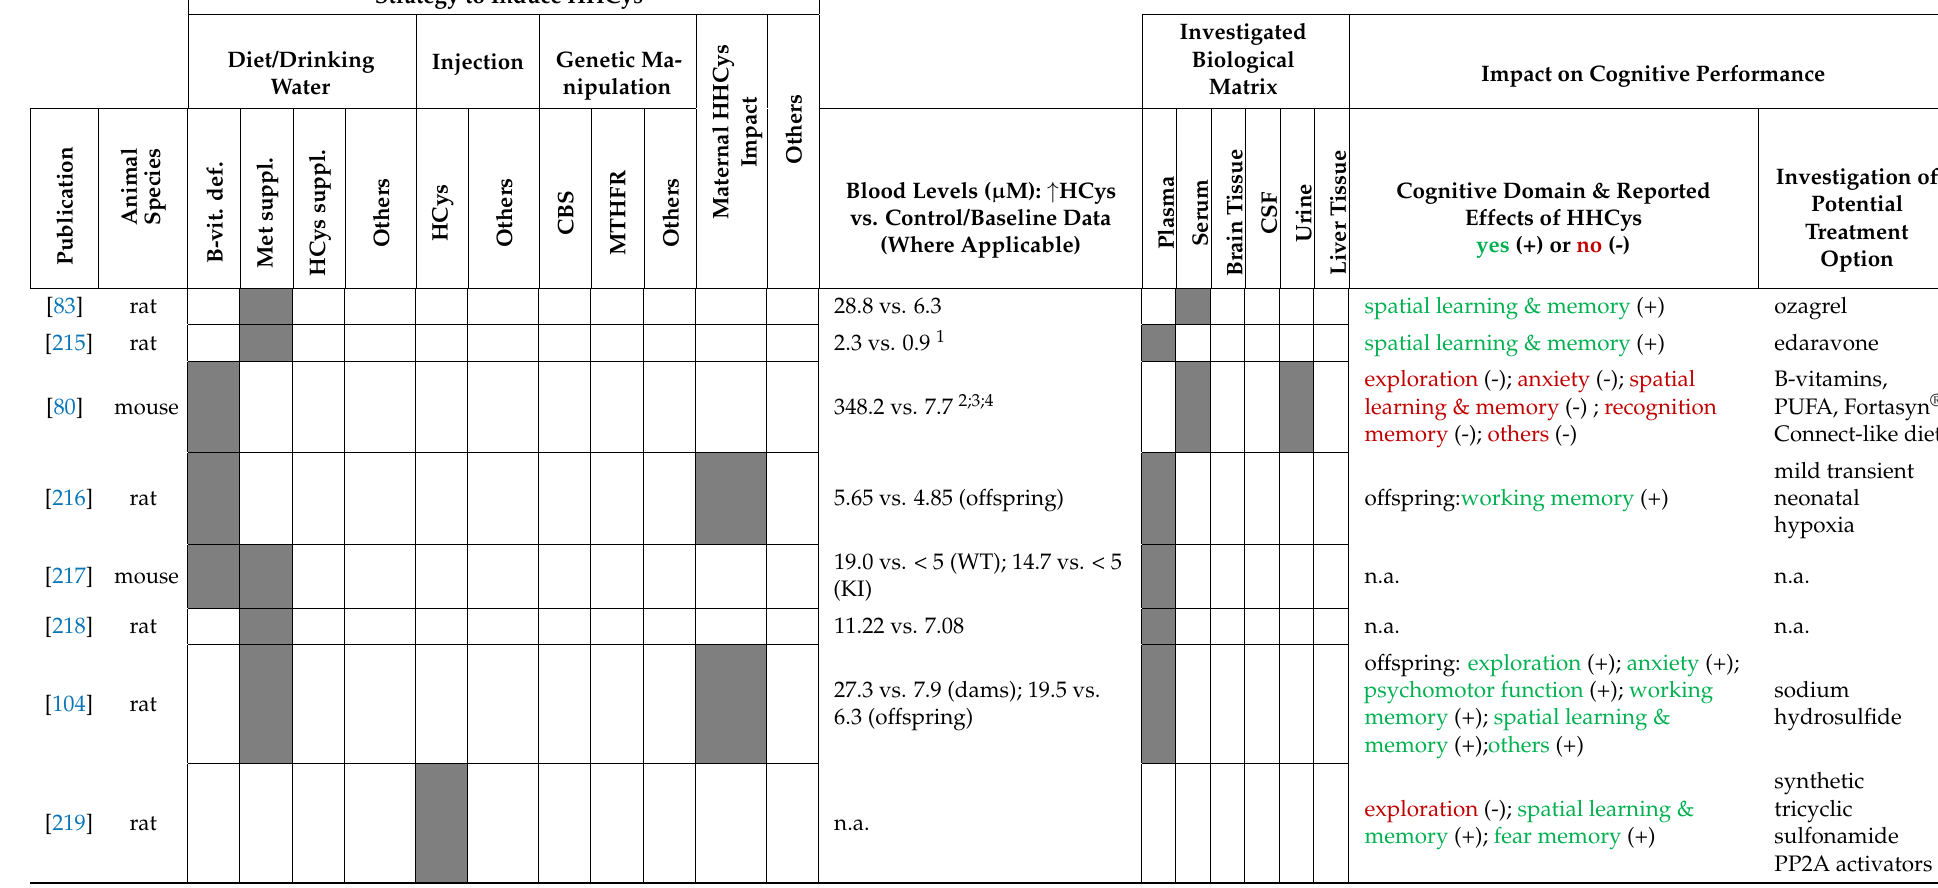
Table A13. Reviewed animal studies derived from the systematic literature search of PubMed/Medline, which served as a basis for further analysis and indicates potential treatment options for elevated HCys levels or related symptoms; abbreviations: WT: wild type, KI: knock-in, KO: knock-out, Tg: transgenic, B-vit. def.: deficiency in B-vitamins (and related substances), Met suppl.: supplementation of L-methionine, CBS: cystathionine β -synthase, MTHFR: methylenetetrahydrofolate reductase, CTH: cystathionine γ